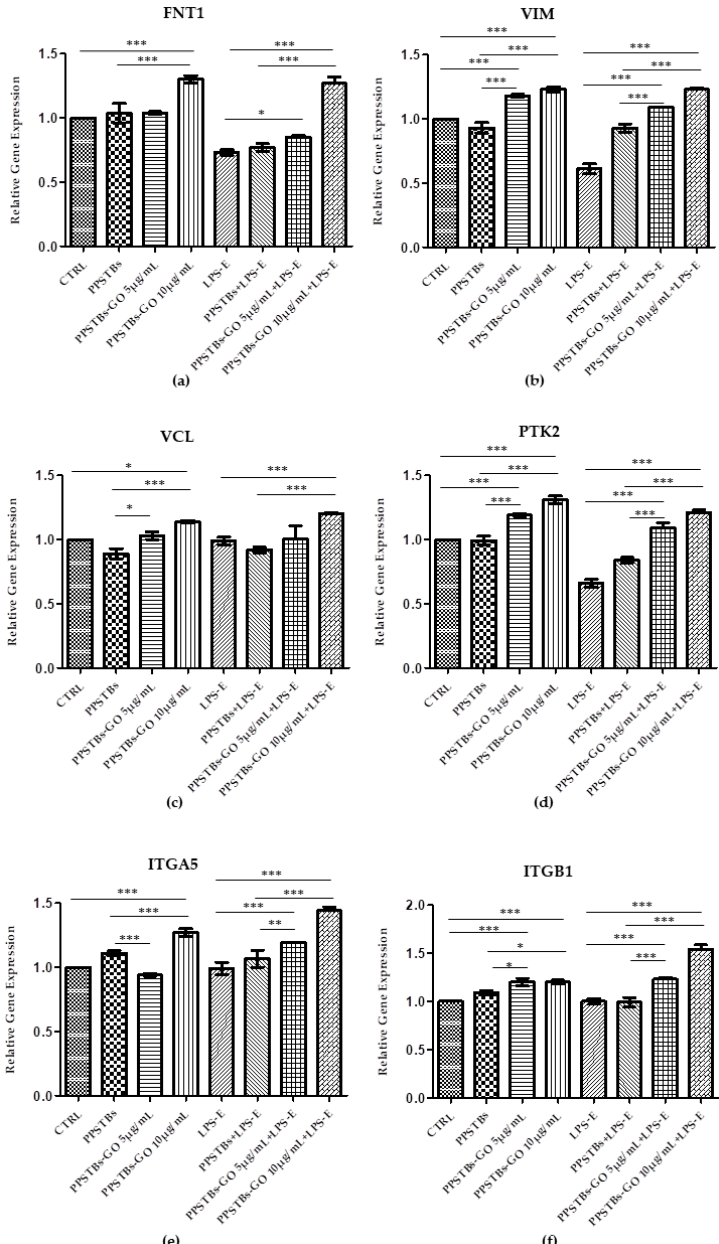
Figure 11. ( a – f ) Histograms of RT ‐ PCR showed the mRNA levels of FNT1, VIM, VCL, PTK2, ITGA5, and ITG1b in untreated cells (CTRL), in hGFs cultured with PPSTBs, in hGFs cultured with PPSTBs enriched with GO at 5 μ g/mL, in hGFs cultured with PPSTBs enriched with GO at 10 μ g/mL, in hGFs stimulated with LPS ‐ E, in hGFs cultured with PPSTBs and stimulated with LPS ‐ E, in hGFs cultured with PPSTBs enriched with GO at 5 μ g/mL and stimulated with LPS ‐ E and in hGFs cultured with PPSTBs enriched with GO at 10 μ g/mL and stimulated with LPS ‐ E. * p < 0.05; ** p < 0.01; *** p < 0.001 .